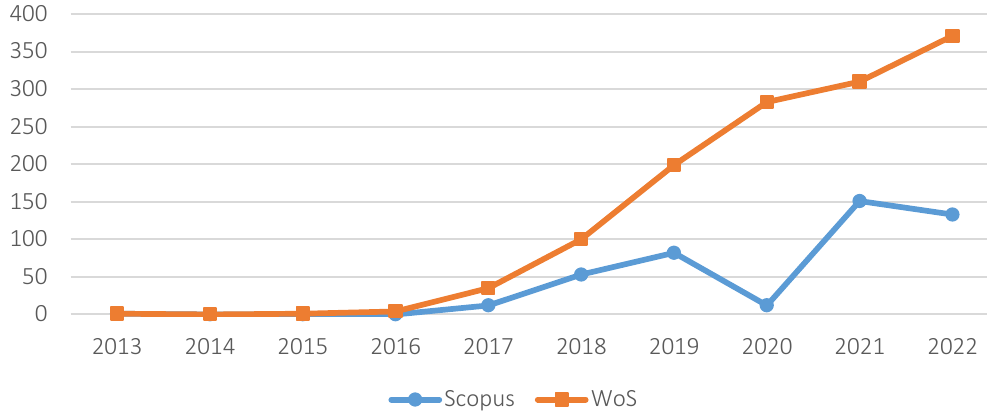
Figure 1. Dynamics of published articles on the topic “blockchain AND accounting” in the scientometric databases Scopus and WoS for